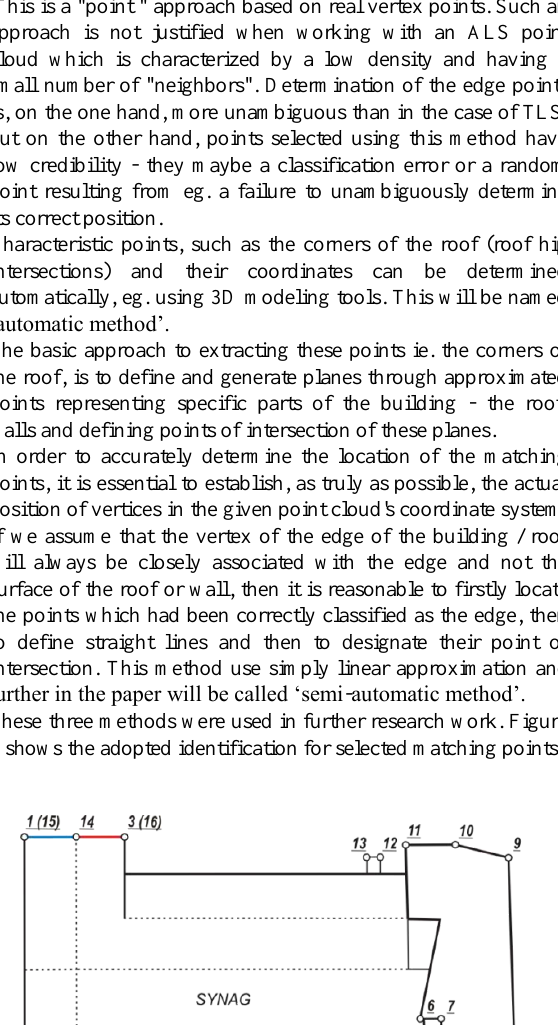
Figure 2. Corner of the synagogue building, A and B – ALS data, C – TLS